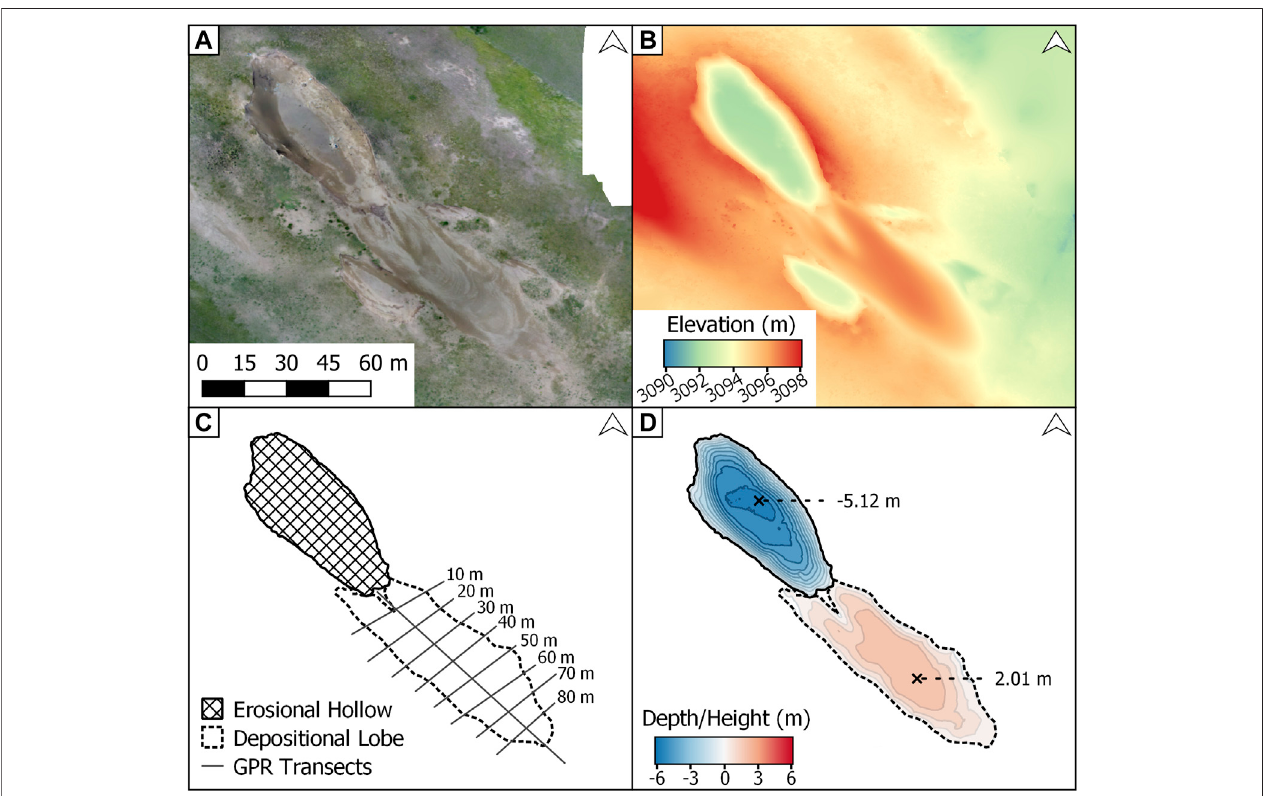
FIGURE 6 | Blowout A viewed as ( A ) a true color composite; ( B ) a digital elevation model; ( C ) a schematic model with ground-penetrating radar transects; and ( D ) interpolatedlobeheightandhollowdepth(contoursat0.5 mspacing).Inthetruecolorcomposite,thelightanddarkertonesonthelobesurfacedenotemoisturecontent of the sand, showing the former shape and extent of the lobe. Coordinates of the top-left corner of the bounding box: 35.95159N, 100.30301E; bottom-right corner: 35.95015N, 100.30458E.